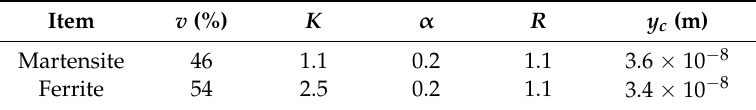
Table 5. The simulated parameters of